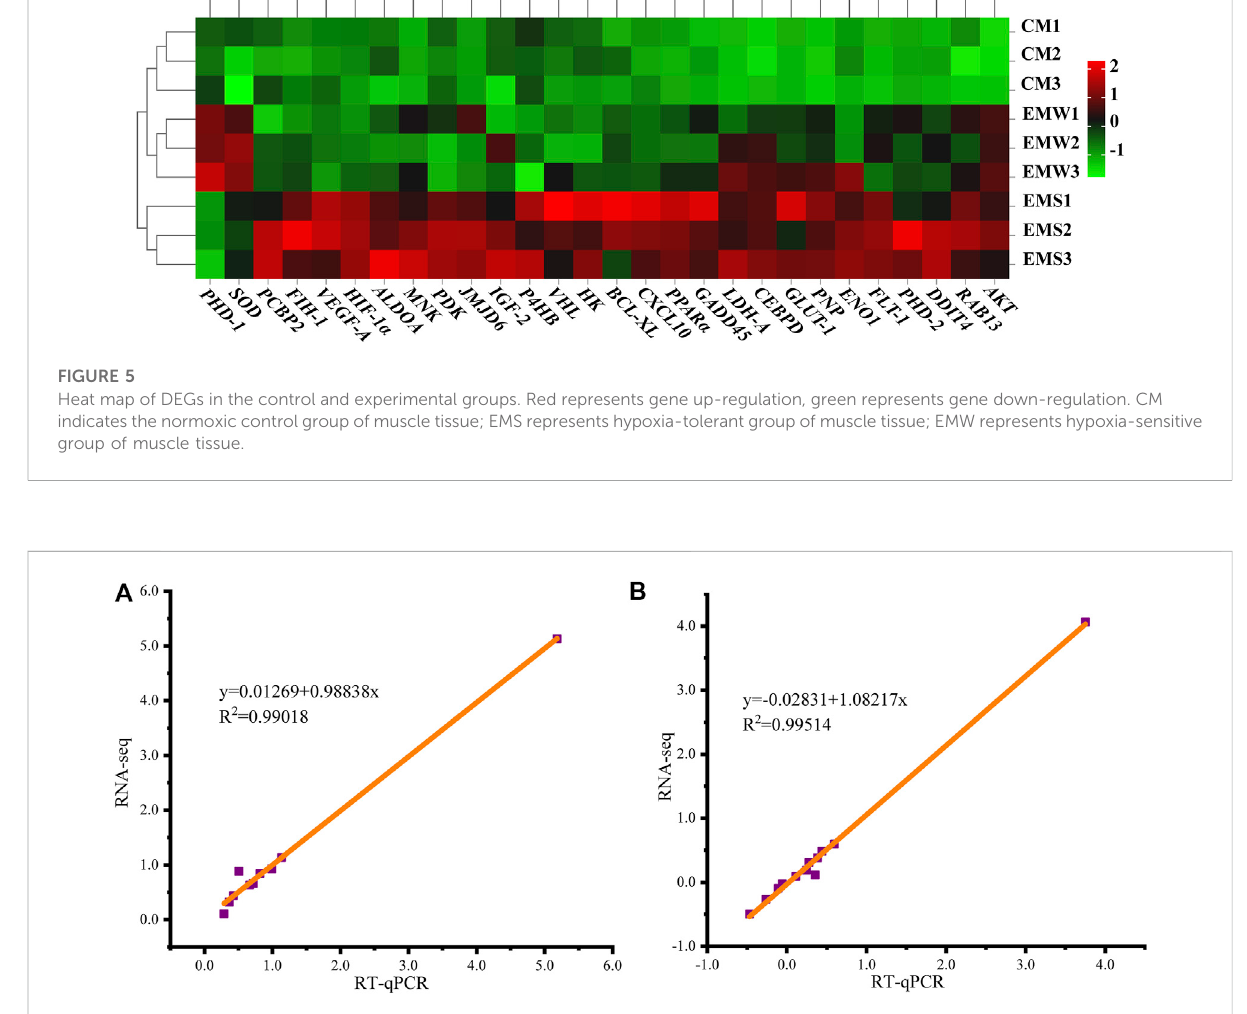
FIGURE 6 FittingcurveofcorrelationbetweenqRT ‒ PCRandRNA-seqgeneexpressionresults.X-axisisthelog 2 FCvalueofqRT ‒ PCR,Y-axisisthelog 2 FC value of RNA-seq, and the red line is the fi tting curve. (A) Correlation analysis of EMS group. (B) Correlation analysis of EMW